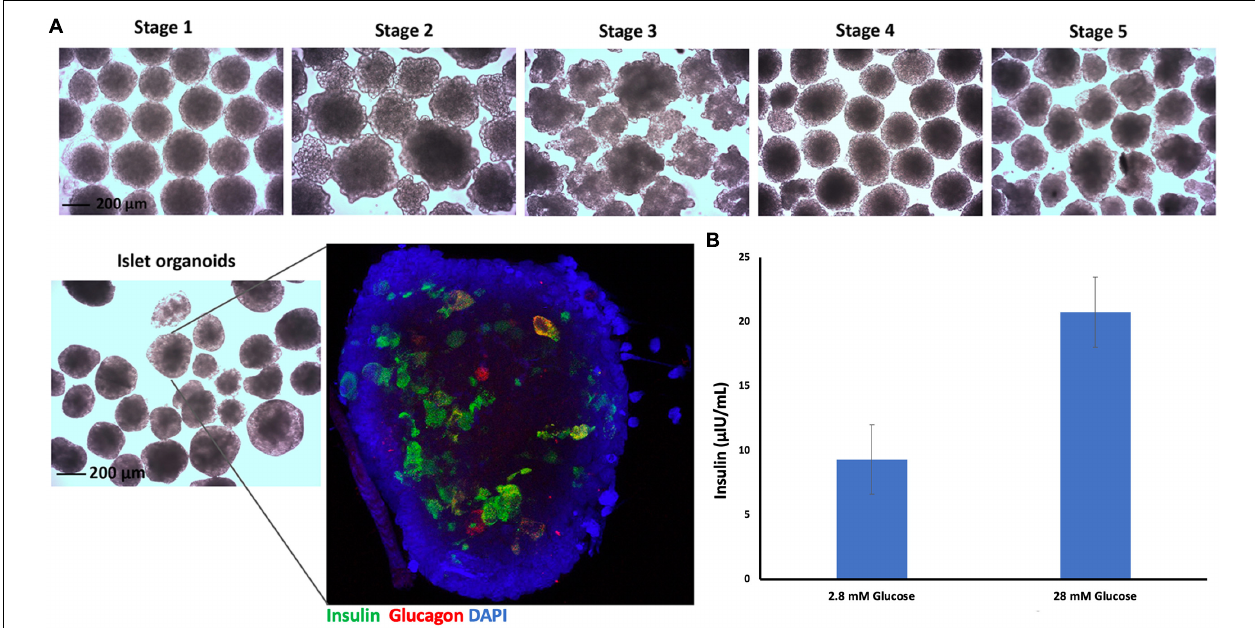
FIGURE 2 | Islet organoids differentiation and characterization. (A) Micrographs of differentiated cell clusters at five stages under light microscopy, magnification bar = 200 µ m. Immunofluorescence staining of differentiated islet organoids. Insulin (green), glucagon (red), and cell nuclei (DAPI, blue), magnification bar = 200 µ m. (B) ELISA measurement of secreted human insulin from islet organoids stimulated with low and high glucose, with a 30-min incubation for each concentration ( n = 3).